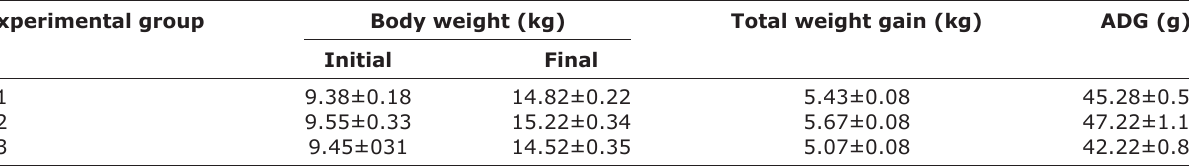
Table-3: Body weight gain (kg) and ADG (g) of kids fed with experimental rations. Experimental group